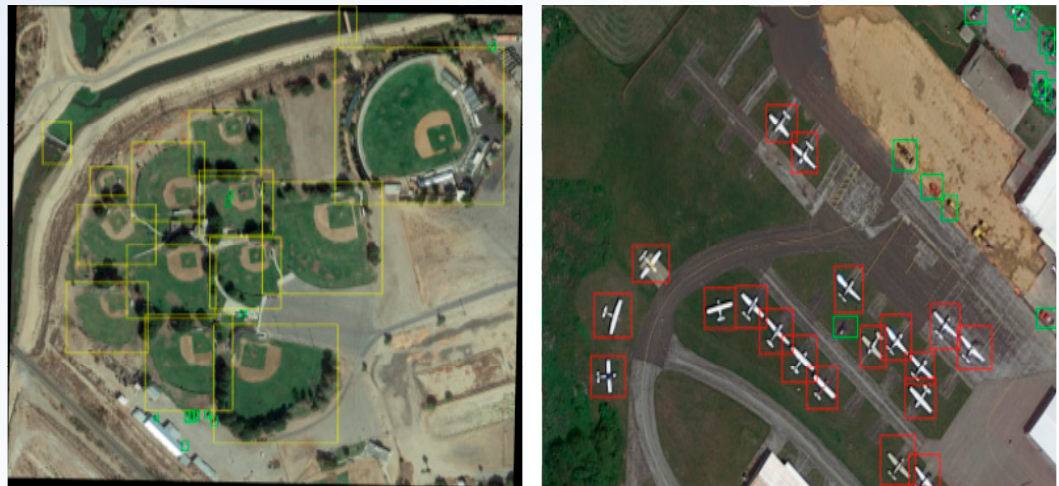
Figure 8. Results of our Network for three categories of objects (ship, building, car).